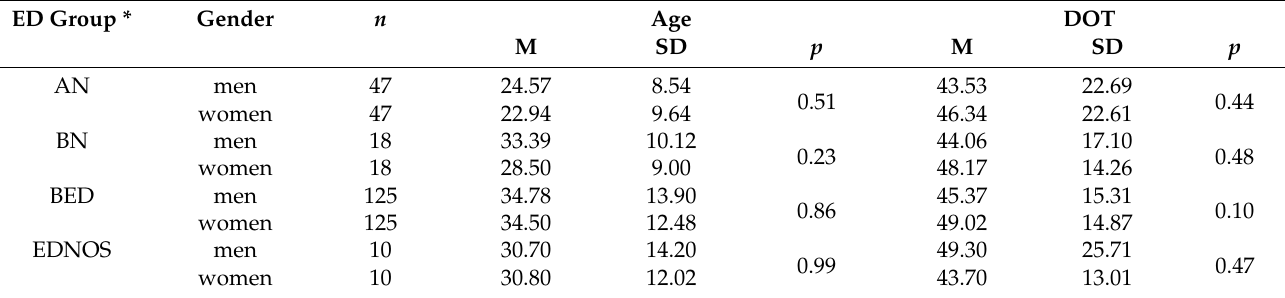
Table 1. Patient and treatment